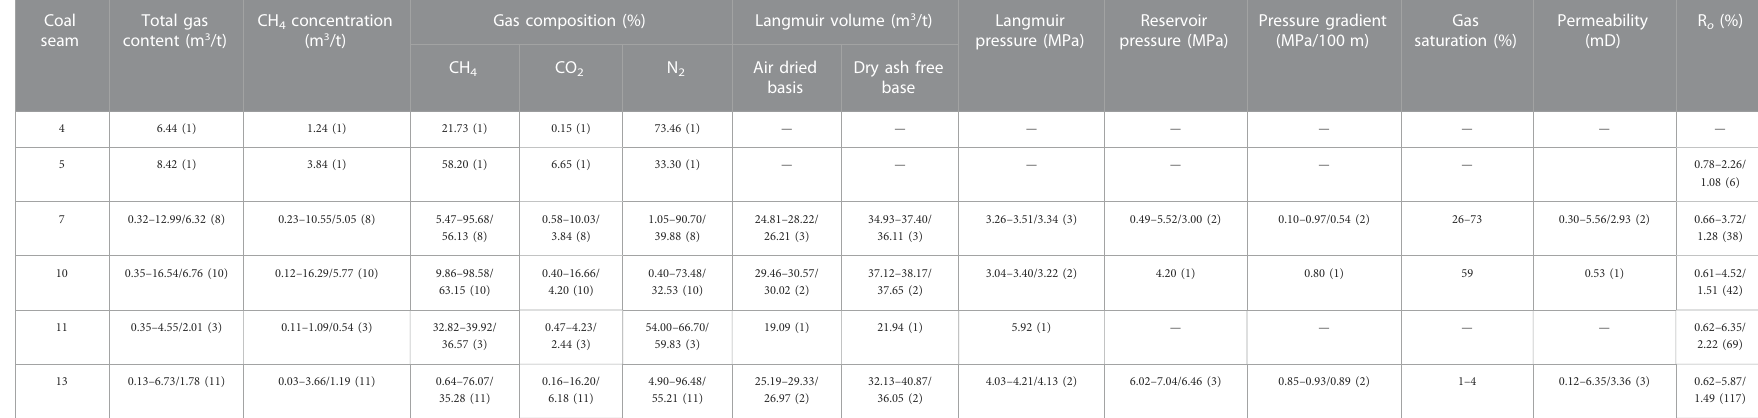
TABLE 4 Analysis results of the CBM content in each coal